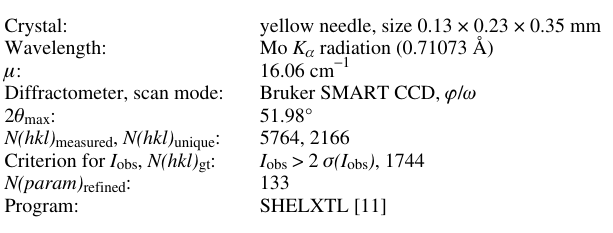
Table 1. Data collection and handling.